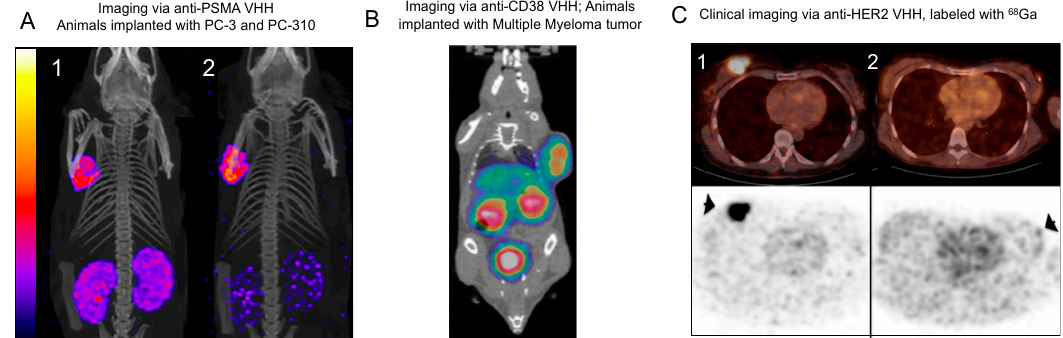
Figure 4. Imaging cancer markers using nanobodies. ( A ) SPECT/CT images of mice bearing PC-3 (right shoulder; PSMA negative) and PC-310 (PSMA expressing) (left shoulder) tumors. Images were acquired 3 h (1) and 24 h (2) after injection of the 111 In-labeled anti-PSMA nanobody with co-injection of gelofusine and lysine. No uptake was observed in the PC-3 tumor on the right shoulder, while PSMA-expressing PC-310 could be visualized [59]. ( B ) Immuno-PET imaging of subcutaneous multiple myeloma. The probe rapidly accumulated within the tumor; images acquired 1 h post-injection [60]. ( C ) HER2 imaging using nanobody was translated in a Phase I clinical trial [58]. Uptake of 68 Ga-HER2-nanobody for assessment of HER2 expression in breast carcinoma by PET/CT (top) and PET (bottom). Patient 1 showed the highest tracer uptake (SUV mean 11.8) while patient 2 showed no uptake (SUV mean 0.9). Both patients were scored 3+ after HER2 IHC analyses.